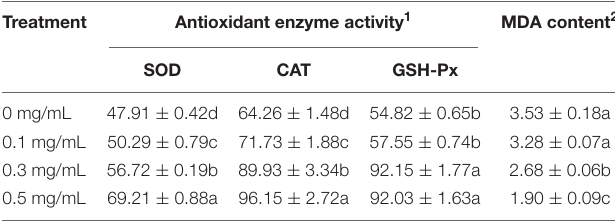
TABLE 1 | Effect of the polysaccharide on the antioxidant enzyme activity and malondialdehyde content of C. elegans .